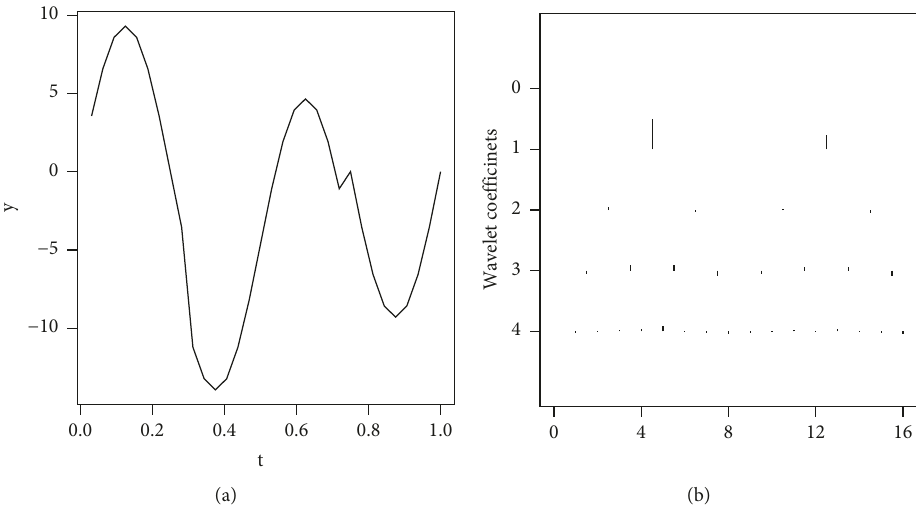
Figure 1: Plots of the artificial data (a), wavelet coefficients of the artificial data at 32 equally spaced